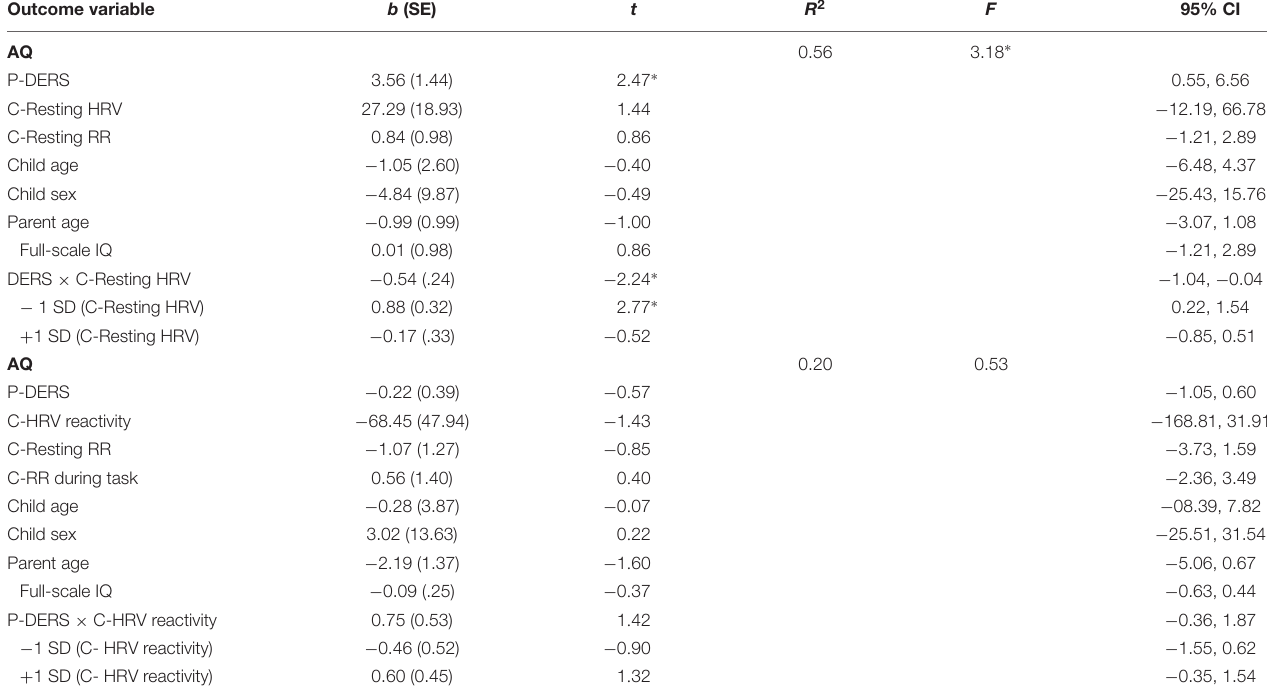
TABLE 2 | Results of moderation analysis on child autism-related characteristics.